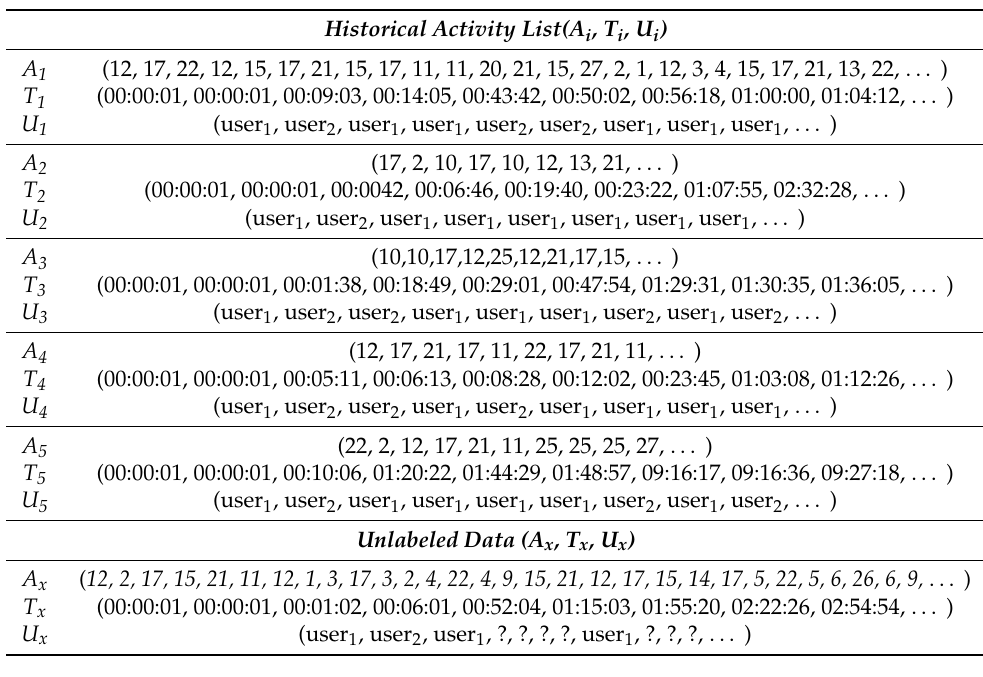
Table 3. Examples of historical activities and unknown user list.